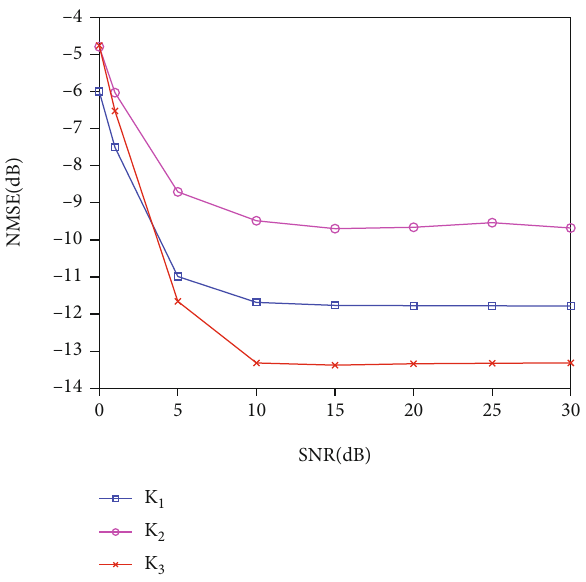
Figure 4: Normalized mean square spectrum estimation error NMSE vs. SNR for di ff erent